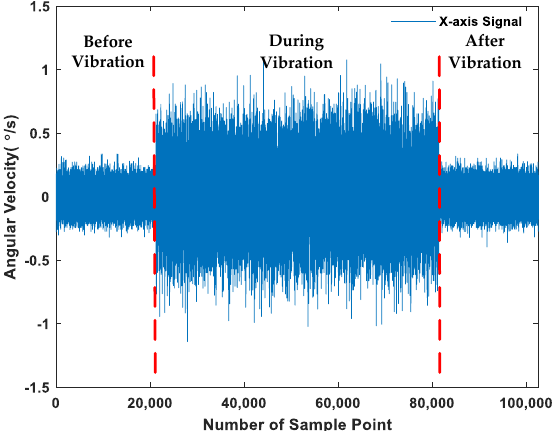
Figure 4. The variation of gyroscope x -axis signal.